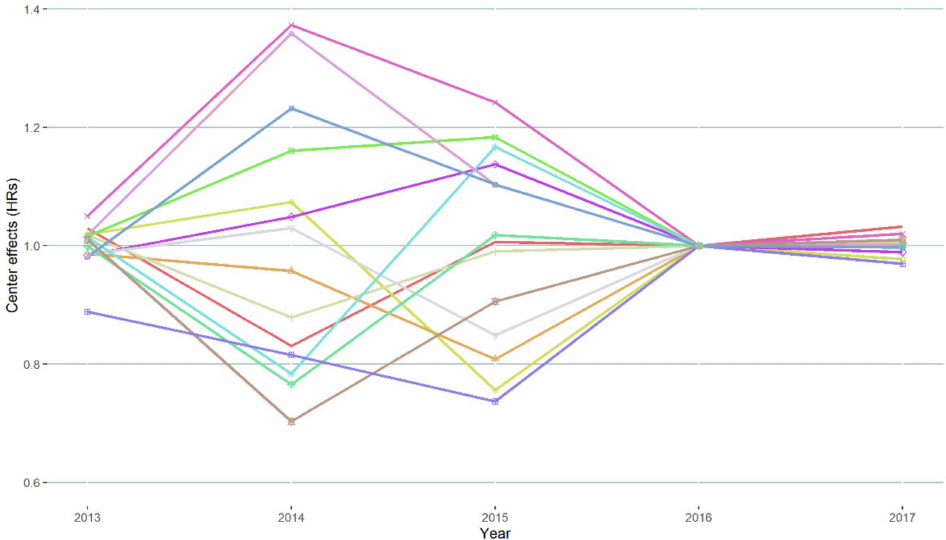
Figure 2. HR for death until 2 years of each center between 2013 and 2017 in model III. Higher ratios mean that a center has a lower observed/expected ratio for 2-year survival corrected for gender, age at diagnosis, ECOG PS, LDH levels, number of organ sites, liver metastases, brain metastases, and BRAFV600 mutational status as covariates in a specific year of diagnosis. HRs = hazard ratios.